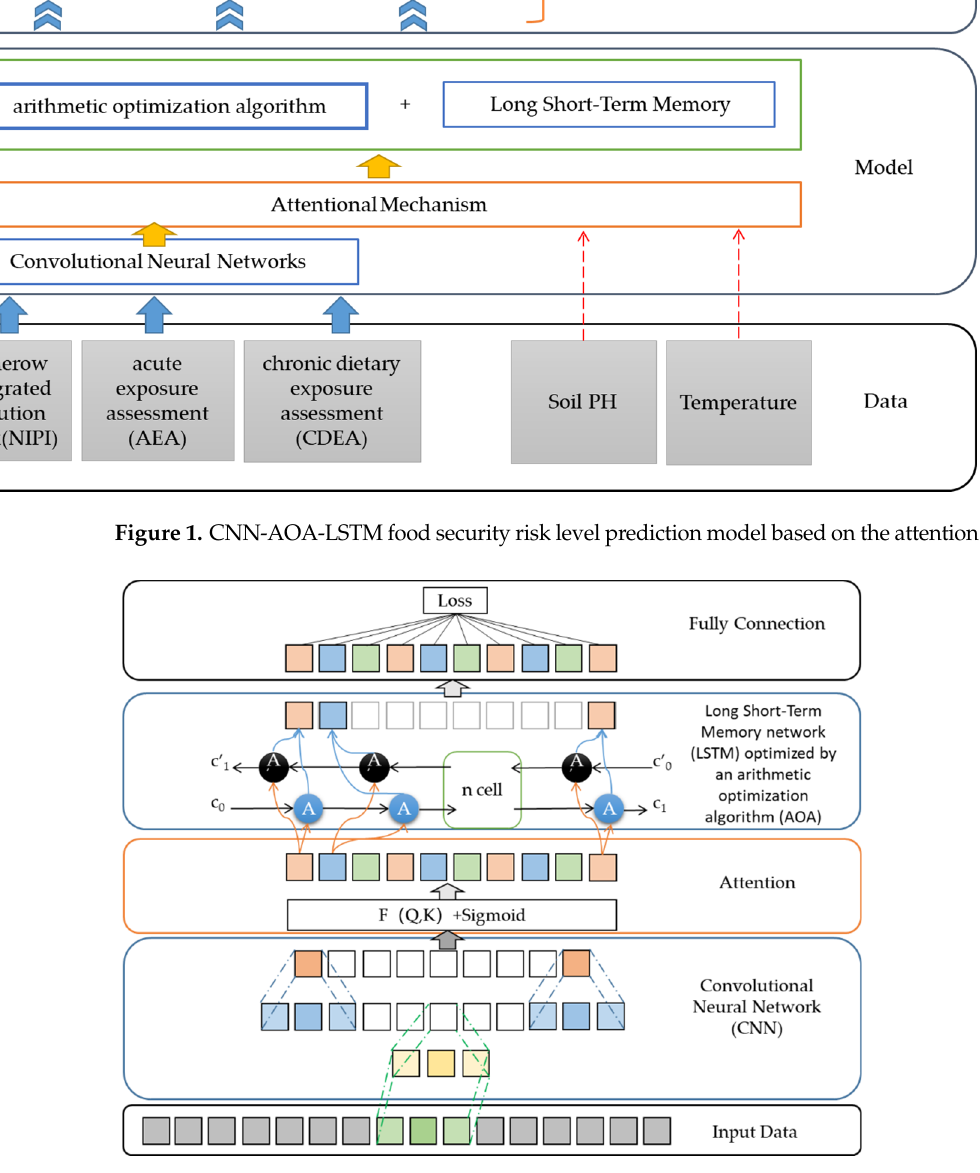
Figure 2. The structure of the neural network model.